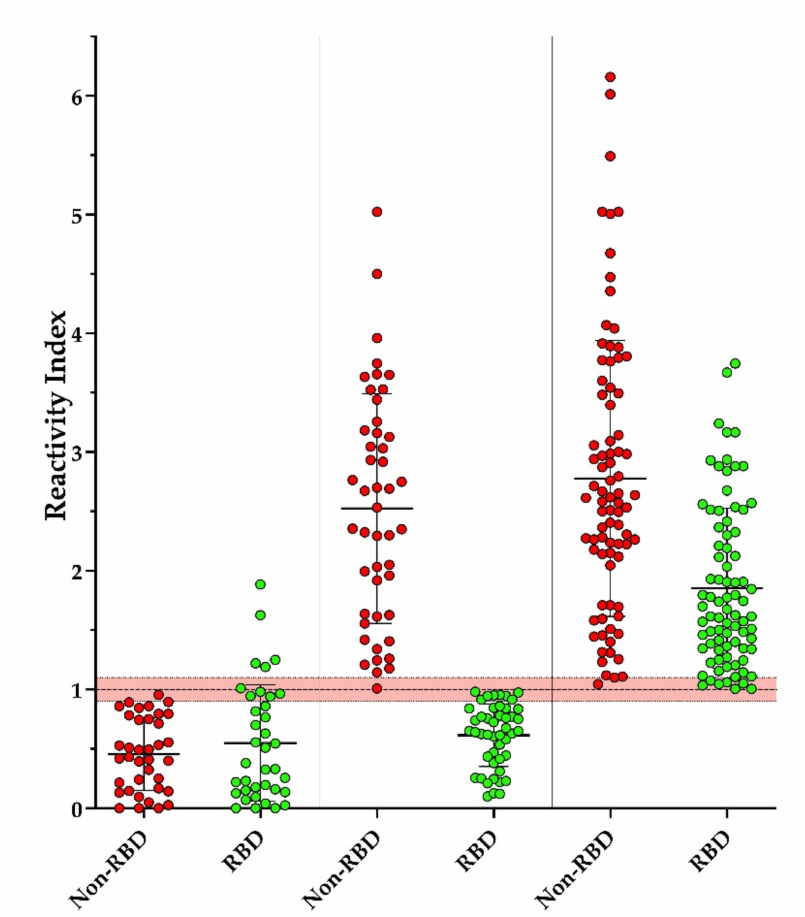
Figure 4. Absence of antibodies toward the RBD in the spike protein of SARS-CoV-2 in a subset of patients positive for anti-SARS-CoV-2 antibodies. Parallel ELISAs were performed using Dx-SARS2- RBD and Dx-SARS2-noRBD proteins as targets for detecting IgG in sera from patients suspected of contact with individuals confirmed with COVID-19 ( n = 166). A reaction index was calculated using the cutoffs determined from the assays performed in Figures 3 and 4. Percentages were calculated from the total number of patients who were reactive for the RBD (3.7%), non-RBD (35.1%), or both (61.2%). The median with standard deviation is